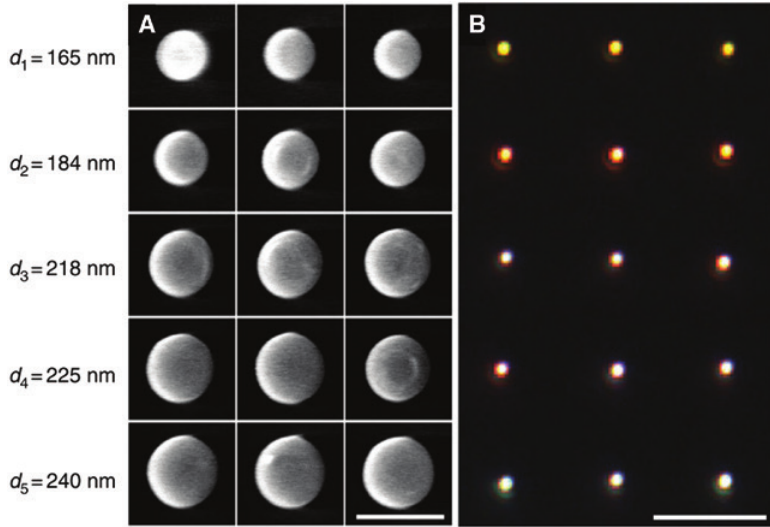
Figure 13: Laser pulse energy dependence of the silicon nanoparticle diameter. (A) SEM images of nanoparticles fabricated at slightly different laser pulse energies starting from 5 nJ. Each line, from top to bottom, corresponds to the laser pulse energy increase of ≈ 0.1 nJ (scale bar, 300 nm). (B) Changes in the optical response of the generated nanoparticles are visualized by dark-field microscopic images (scale bar, 5 mm). Reprinted with permission from Ref.